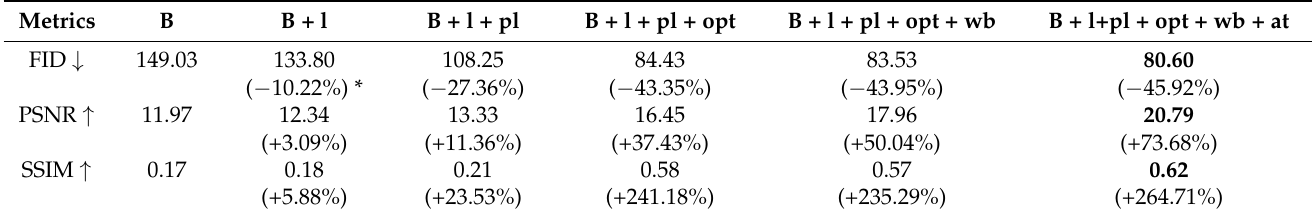
Table 4. Evaluation metrics results of the ablation study.